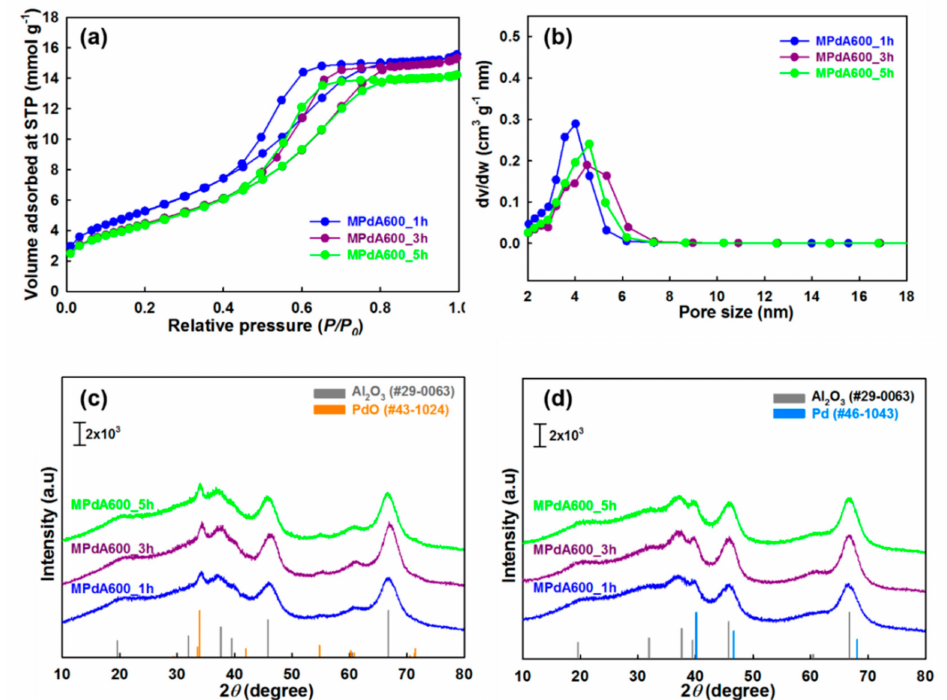
Figure 7. ( a ) Nitrogen adsorption-desorption isotherms; ( b ) pore size distributions; ( c ) XRD patterns of the MPdA catalysts calcined at 600 ◦ C for di ff erent durations; ( d ) XRD patterns of the MPdA catalysts reduced at 350 ◦ C for 3 h; X-ray source: Cu K α (1.5406 Å). Table 2. Physicochemical properties of the MPdA catalysts calcined at 600 ◦ C for di ff erent durations. Catalyst